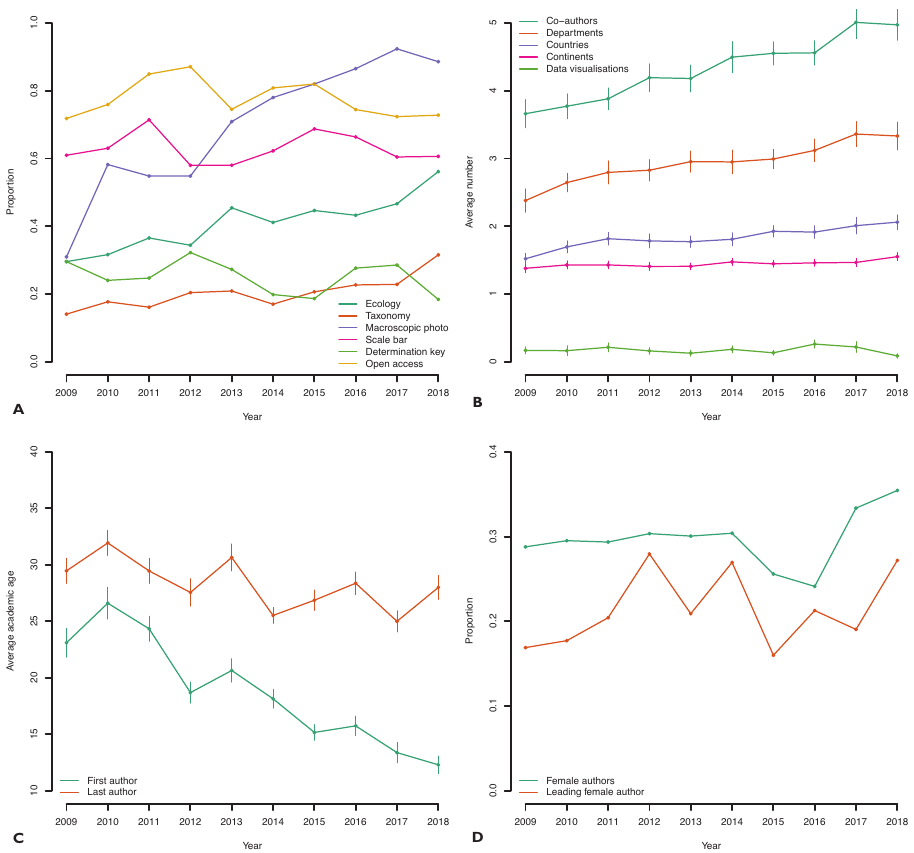
Figure 1. A Data and metadata in the description of fungal species 2009–2018. The x axis depicts year and the y axis depicts proportion of studies (from 0 to 1) fulfilling a specific criterion. Dark green – proportion of studies mentioning the word “ecology” or its variations; brown – proportion of studies giving a complete account of the taxonomic affiliation of the new species (family, order, and phylum); purple – proportion of studies with a macroscopic colour photo/illustration of the new species; pink – proportion of studies with macroscopic photos, that also indicate the size of the depicted object through a scale bar or a fiducial marker; light green – proportion of studies with an identification key; yellow – proportion of openly available papers for each year as assessed in 2020 B demographical and publication trends showing the average number of co- authors (dark green), departments (brown), countries (purple), continents (pink), and number of data visuali- zations (light green) over time. The bars indicate the yearly standard error C the average academic age of the first (green) and last (brown) co-author over time. The bars indicate the yearly standard error D the proportion of female co-authors (green) over time plus the proportion of female lead authors